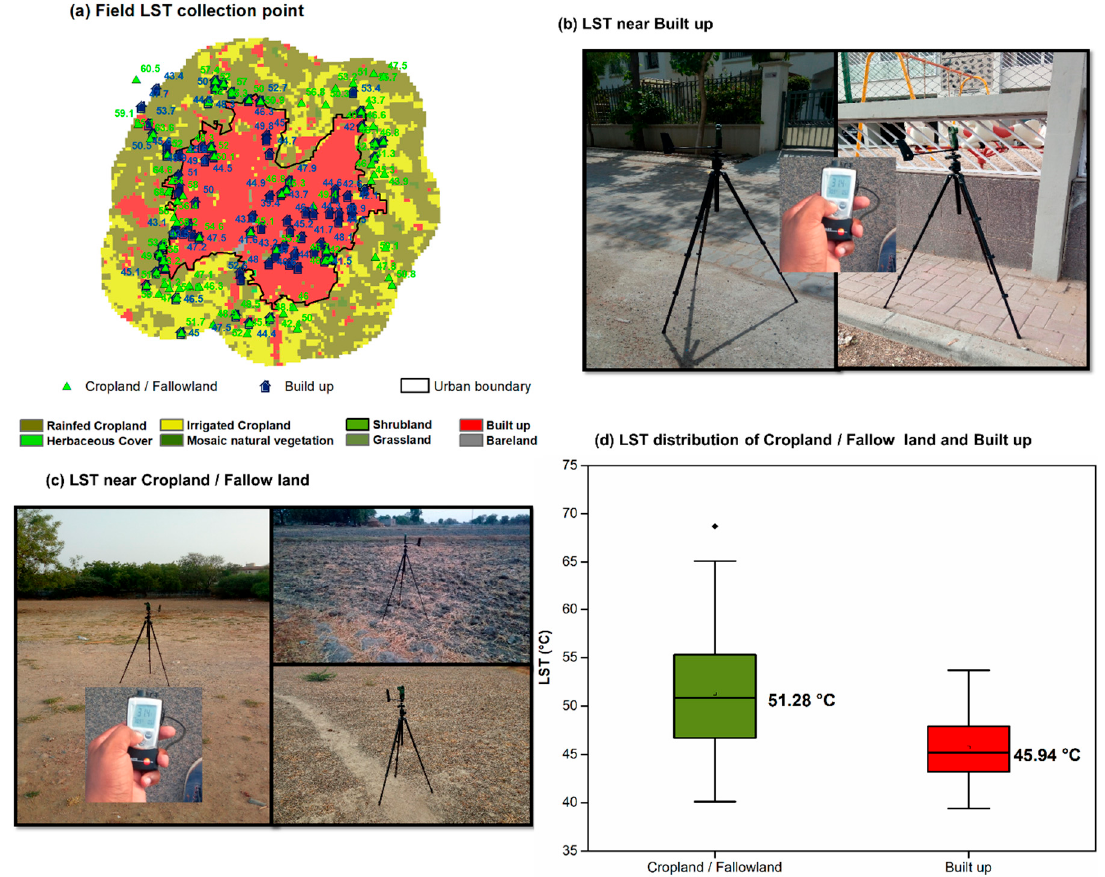
Figure 13. ( a ) Field campaign (2 to 11 May 2018) for LST in situ measurements over built-up (blue symbol) and cropland (green symbol) locations; ( b ) LST recording in built up locations; ( c ) LST recording in cropland/fallowland locations; ( d ) LST distribution of built-up and cropland/fallowland through a boxplot.